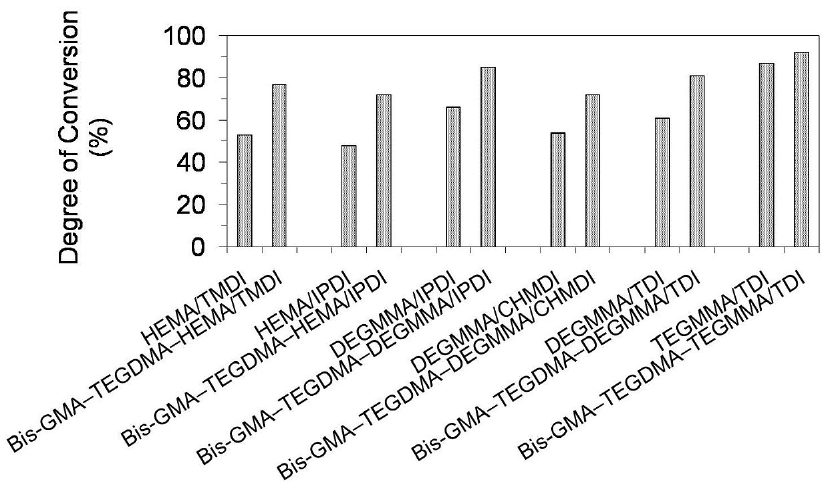
Figure 9. The degree of conversion in homopolymers and copolymers composed of UDMA, Bis-GMA and